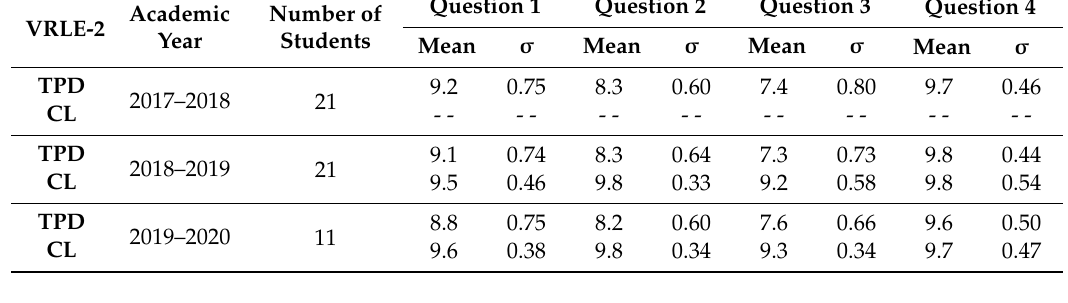
Table 3. Mean and standard deviation ( σ ) of students’ scores from surveys given from 2017 to 2020 to each question of the Table 1 for VRLEs developed later (VRLE-2, Figure 4).